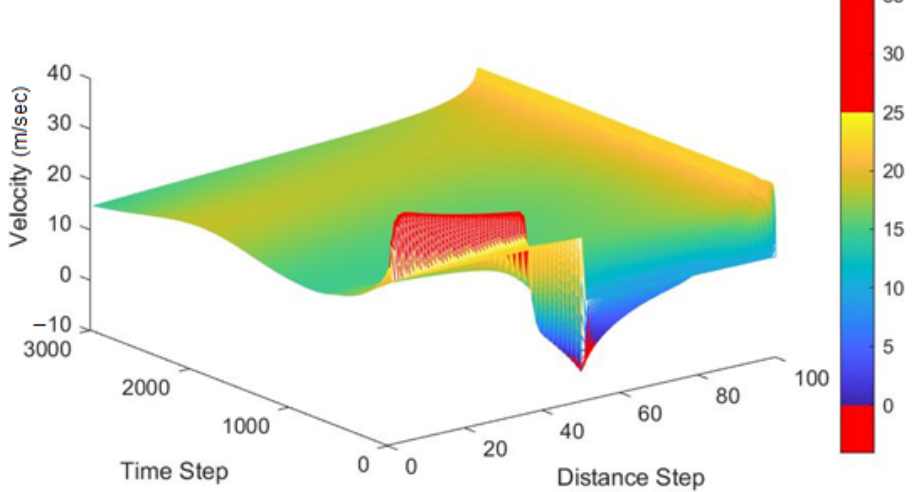
Appl. Sci. 2021 , 11 , x FOR PEER REVIEW Figure 2. Velocity behavior of PW model on straight road with ingress traffic. Figure 2. Velocity behavior of PW model on straight road with ingress traffic.